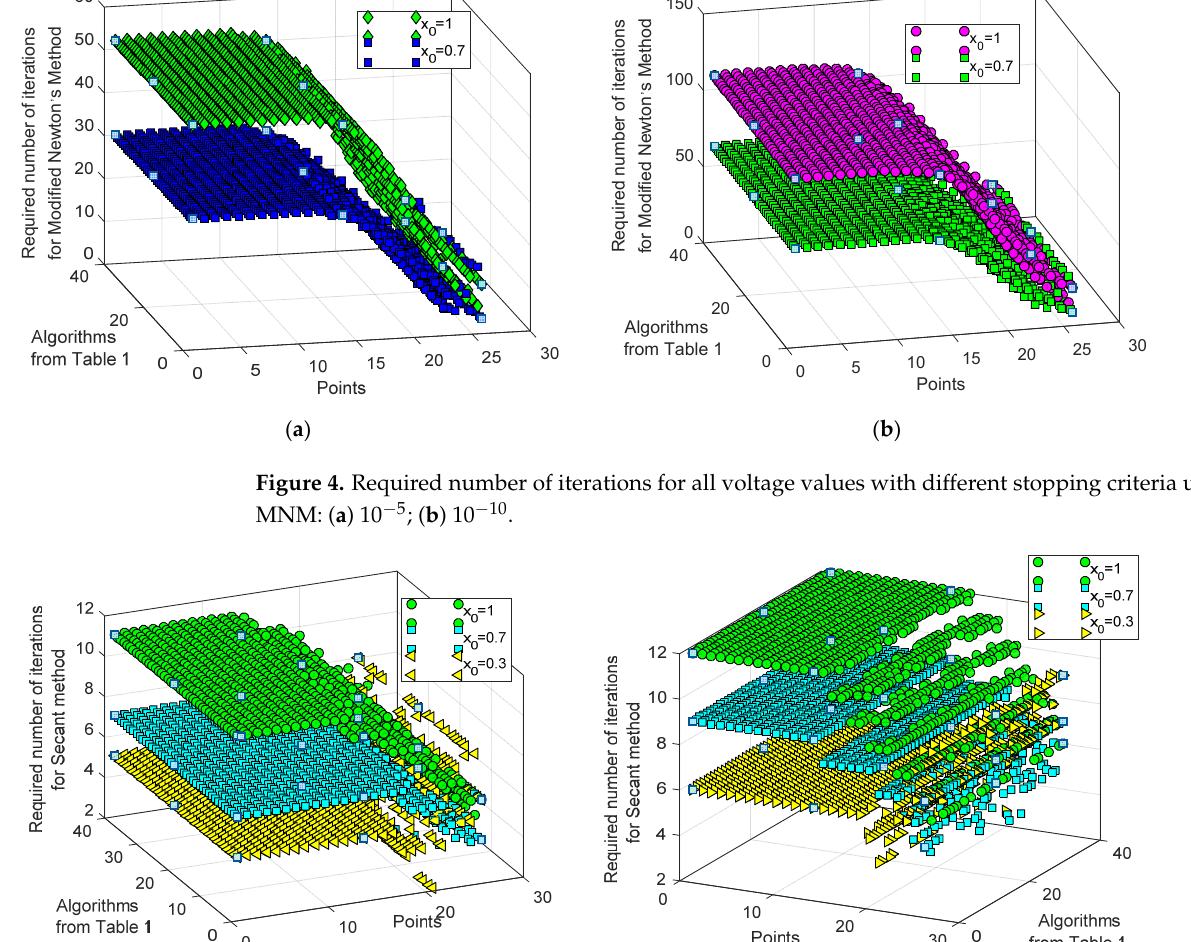
( b ) Figure 6. Required number of iterations for all voltage values with different stopping criteria using RFM: ( a ) 10 − 5 ; ( b ) 10 − 10 .